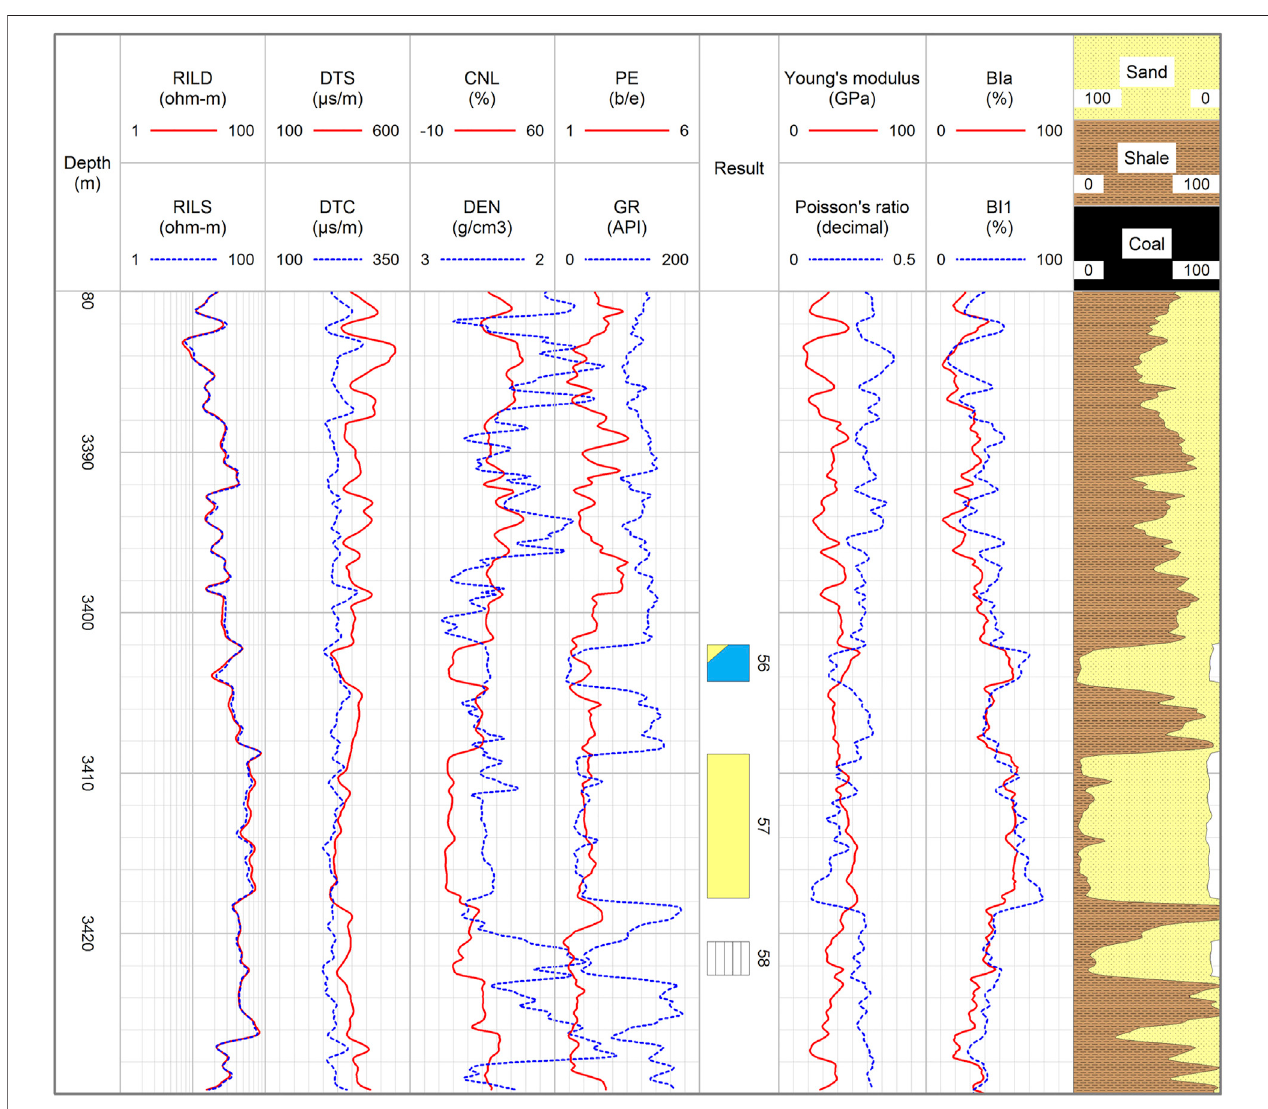
FIGURE 5 | Well #2 logging interpretation results of He8